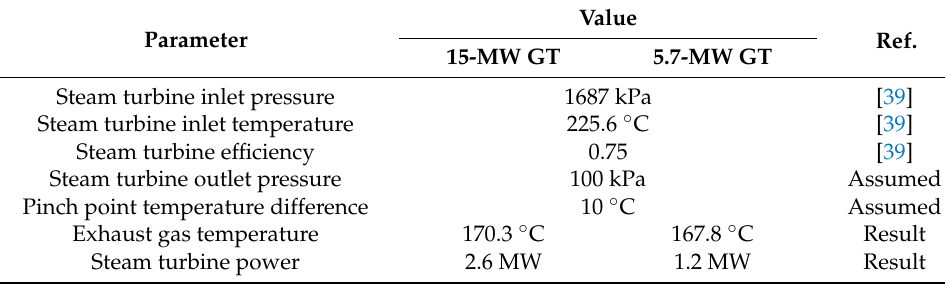
Figure 6. Configuration of the bottoming cycle. Table 2. Design parameters of the bottoming